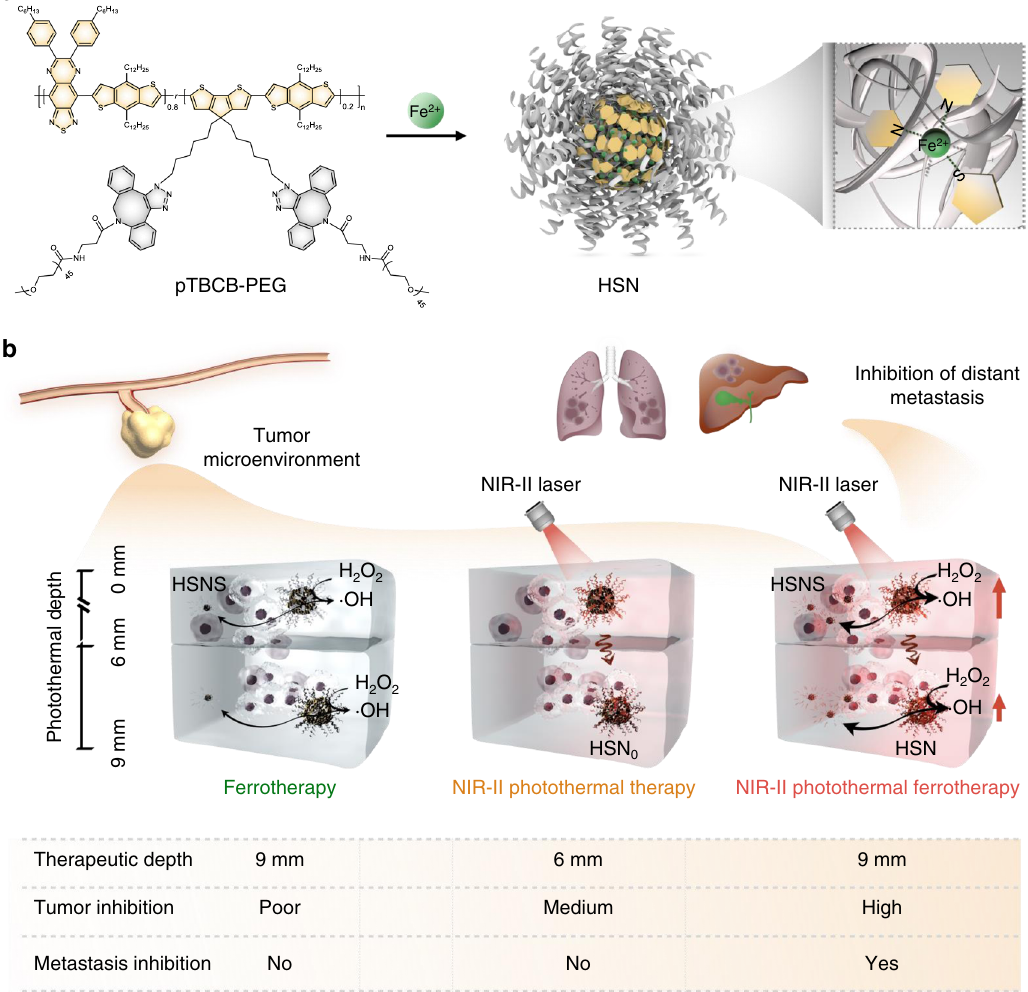
Fig. 1 Schematic illustration of HSN for NIR-II photothermal ferrotherapy. a Chemical structure of pTBCB-PEG, preparation of HSN, and proposed mechanism of iron chelation. b Comparison of HSN-mediated NIR-II photothermal ferrotherapy with monotherapies (ferrotherapy and